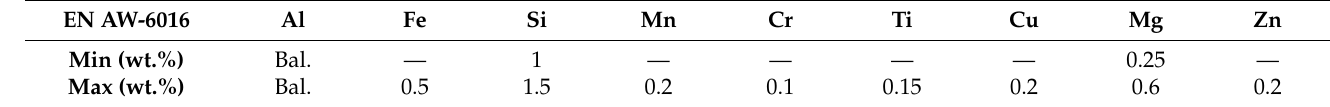
Table 1. Composition limits of EN AW-6016 [11].